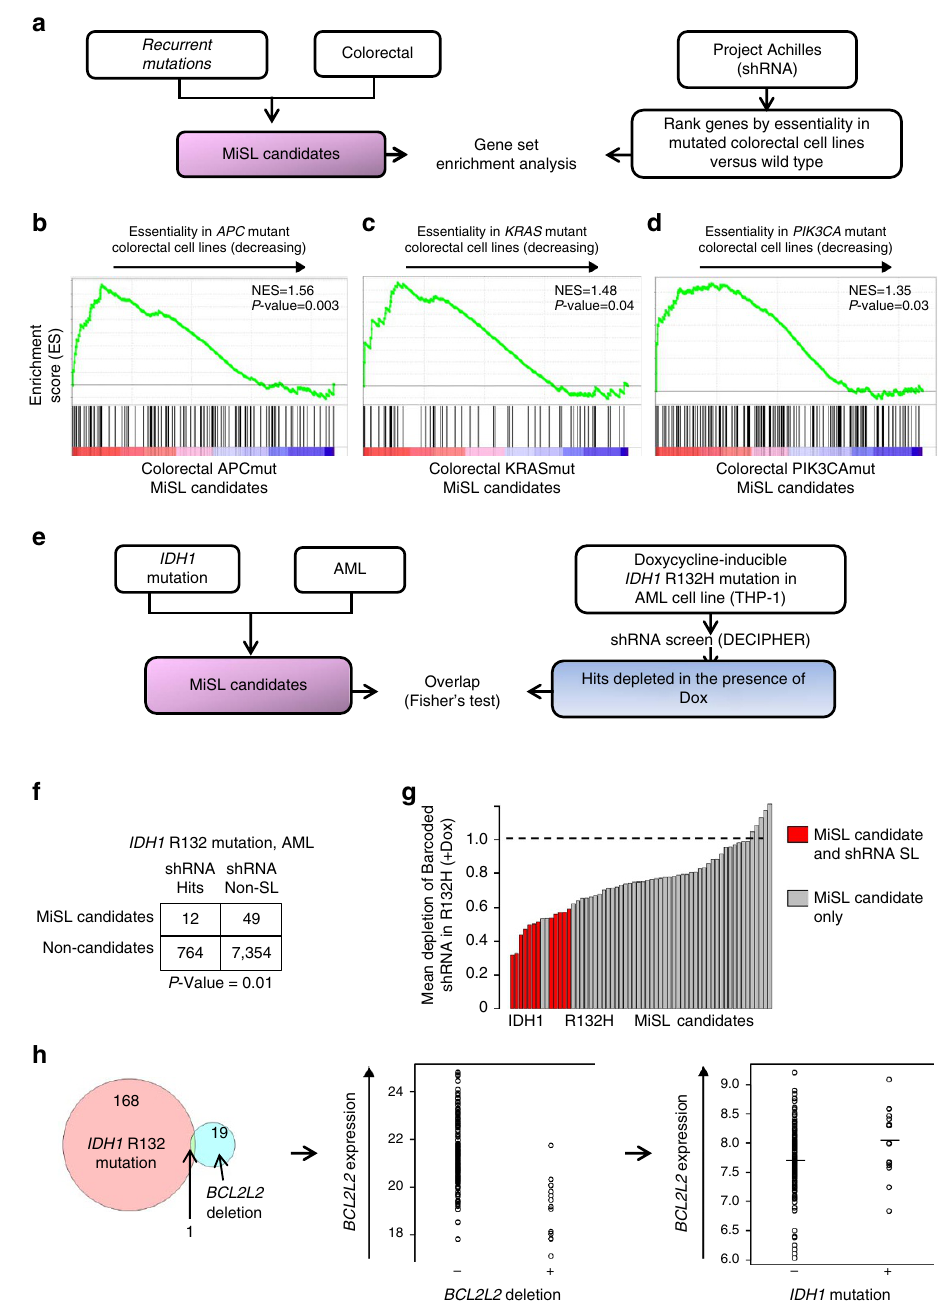
Figure 2 | MiSL predictions are enriched for mutation-specific SL partners. ( a ) Schematic for comparing MiSL predictions for mutations in colorectal cancer with essential genes as per the shRNA data from Project Achilles. ( b – d ) Gene set enrichment plots assessing the degree of enrichment of MiSL candidates for mutations in colorectal cancer using the data from Project Achilles. Genes were ranked according to selective essentiality in mutated colorectal cancer cell lines versus wild-type cells using the shRNA data from Project Achilles. Enrichment analysis was done using GSEA to compare the ranked list of genes for each mutation with its MiSL candidates in colorectal cancer. A positive enrichment score meant that MiSL candidates were ranked near the top of the list for each mutation. ( b ) Enrichment plot for APC mutation in colorectal cancer (NES ¼ 1.55, P value ¼ 0.003). ( c ) Enrichment plot for KRAS mutation in colorectal cancer (NES ¼ 1.48, P value ¼ 0.04). ( d ) Enrichment plot for PIK3CA mutation in colorectal cancer (NES ¼ 1.35, P value ¼ 0.03). ( e ) Schematic for comparing MiSL candidates for IDH1 mutation in AML with SL partners as per DECIPHER library screen generated using a Dox-inducible IDH1 R132H THP-1 cell line. ( f ) Overlap between MiSL candidates and SL partners as per the DECIPHER screen for the IDH1 mutation in AML is statistically significant ( P value ¼ 0.01, Fisher’s exact test). ( g ) Plot summarizing average shRNA scores for hairpins for the 61 MiSL candidates represented in the DECIPHER screen. ( h ) MiSL analysis steps illustrated for BCL2L2 —(i) mutual exclusion of IDH1 mutation and gene deletion across cancers (HI-LO Boolean implication), (ii) deletion of gene concordant with lower expression of gene ( P o 0.05) and (iii) expression of gene is higher in IDH1 -mutated AML ( P o